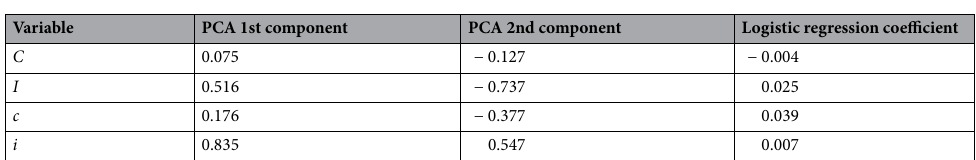
Table 1. PCA component weights and coefficients from fitting a logistic regression to the data. The variables are notated as first neighbor country ( C ), first neighbor industry ( I ), second neighbor country ( c ) and second neighbor industry ( i